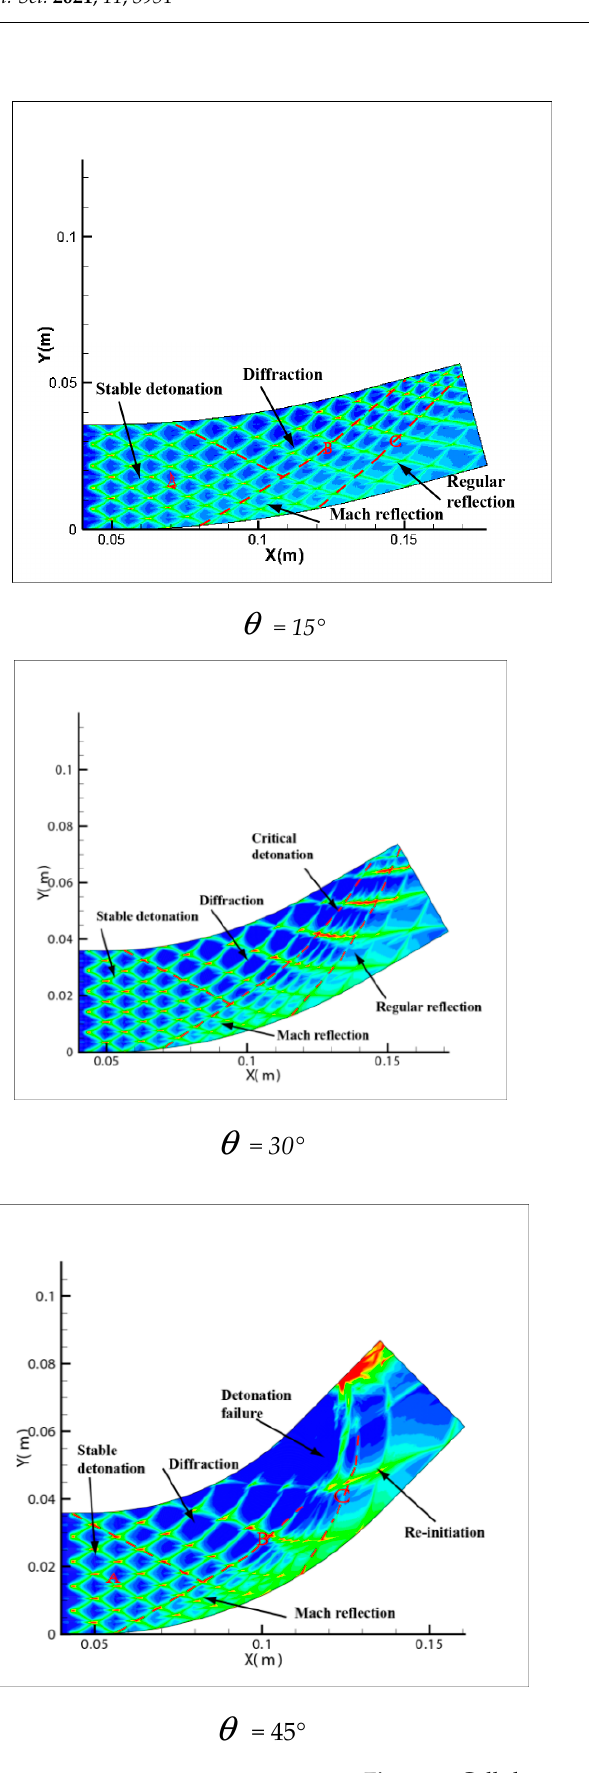
Figure 6. Cellular structure of different bend angles.